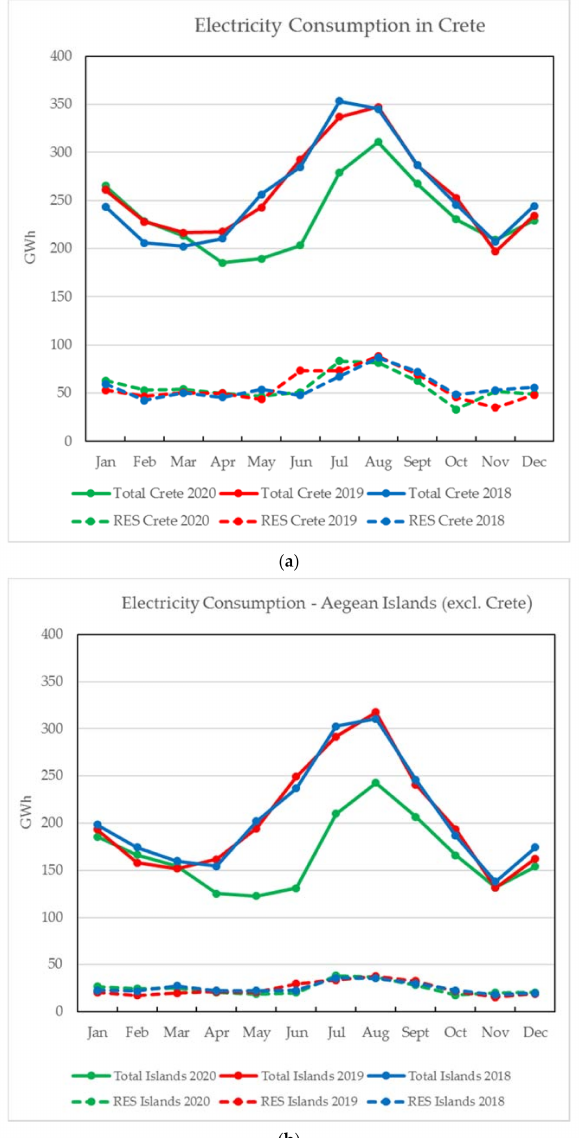
Figure 6. ( a ) Monthly amounts of total electricity consumption in Crete and generation from RES installations for 2018, 2019, and 2020 (GWh); ( b ) monthly amounts of total electricity generation by all stations in the Aegean islands (excluding Crete) and those from RES installations for 2018, 2019, and 2020